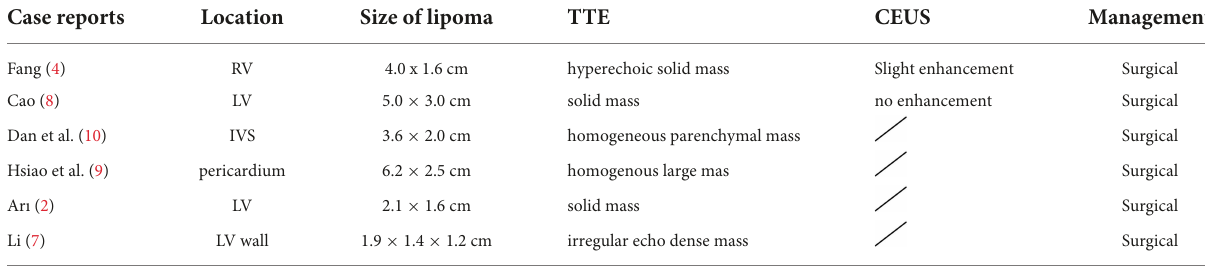
TABLE 1 Literature review of cardiac lipoma case